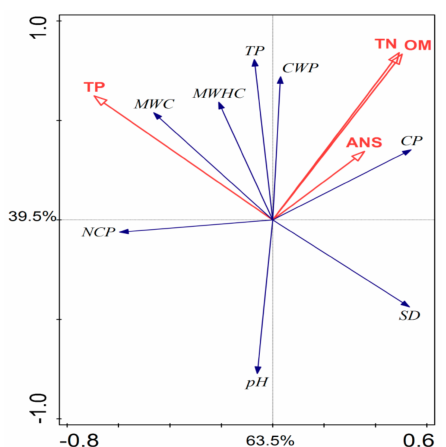
Figure 3. Ordination plot of results from redundancy analysis to identify the relationship of soil chemical properties with soil physical properties. Note: Maximum water capacity (MWC); maximum water holding capacity (MWHC); capillary water capacity (CWP); capillary porosity (CP); non-capillary porosity (NCP); total porosity (TPo); soil density (SD); soil pH (pH:); total phosphorus (TP); organic matter (OM); total nitrogen (TN); available phosphorus (AP); alkaline N solution (AN).